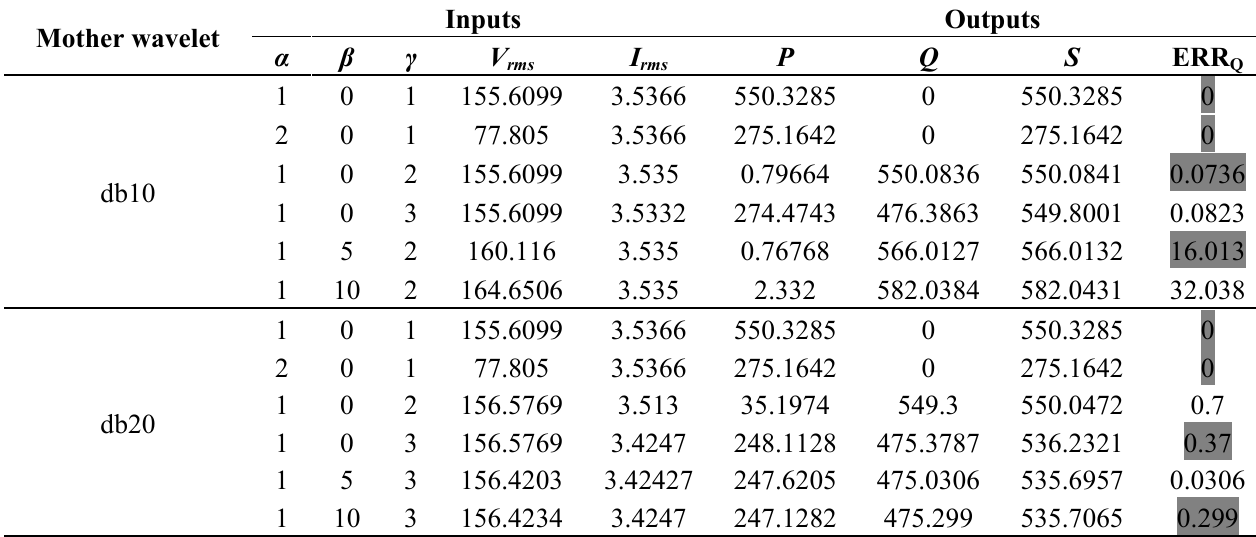
Table 3. Results for case study 1.